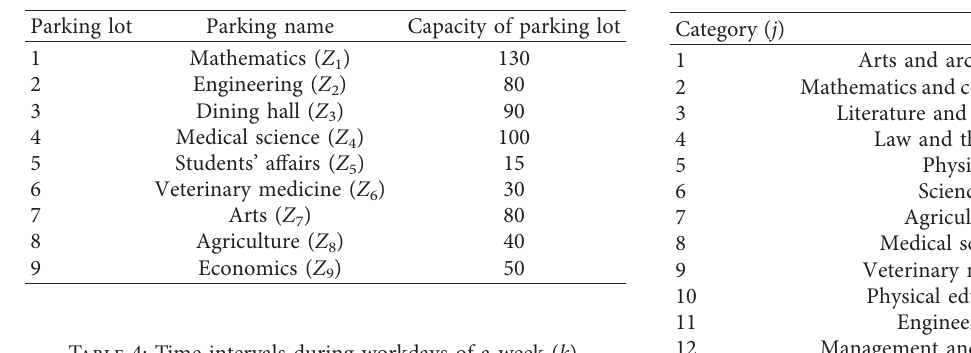
Table 4: Time intervals during workdays of a week ( k ). Time interval